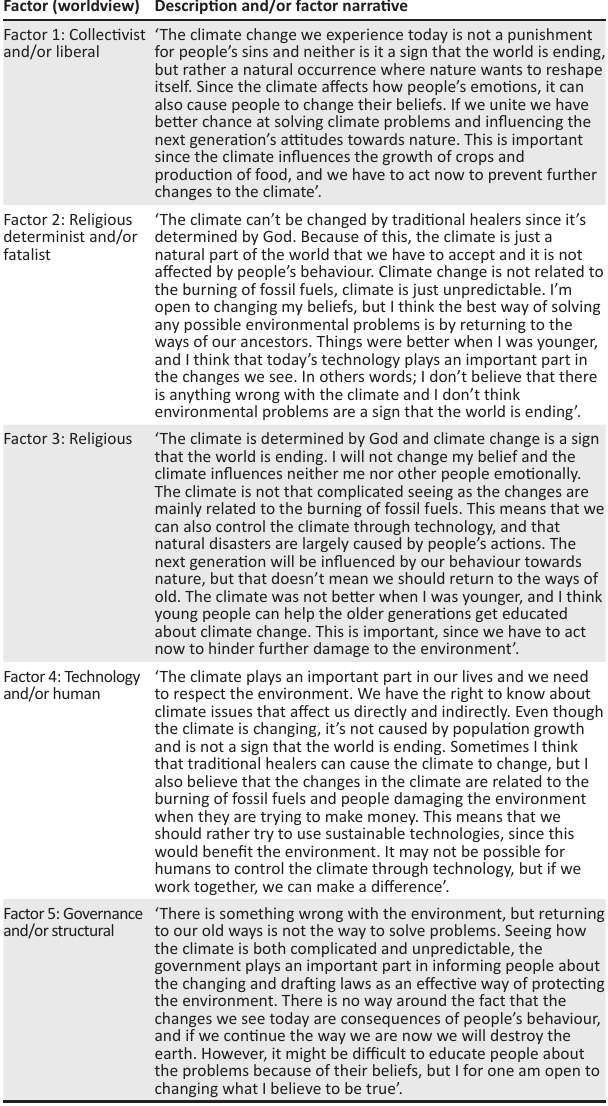
TABLE 1: Factors and their descriptions. Factor (worldview) Description and/or factor narrative